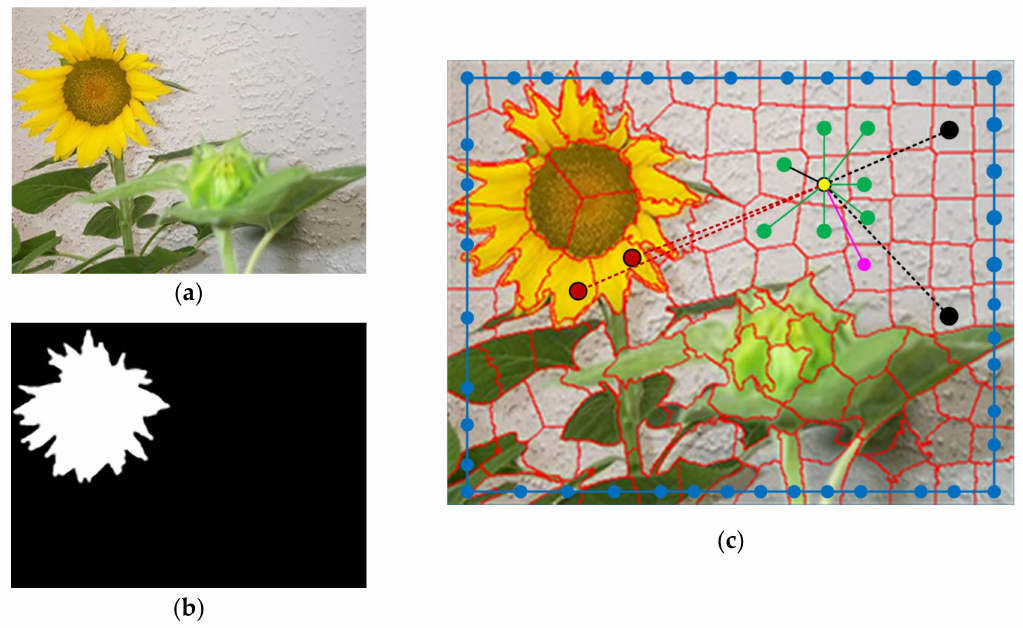
Figure 4. The proposed Graph model. ( a ) Input image. ( b ) Ground truth. ( c ) A diagram of the connections of one of the nodes. A node (illustrated by a yellow dot) connects to its adjacent nodes (green dot and local connection) and the most similar node (pink dot and local connection) sharing common boundaries with its adjacent nodes. Additionally, each node connects to the “true-foreground” nodes (red dot and nonlocal connection) and the “true-background” nodes (black dot and nonlocal connection). Each pair of boundary nodes connects to each other (blue dot and local